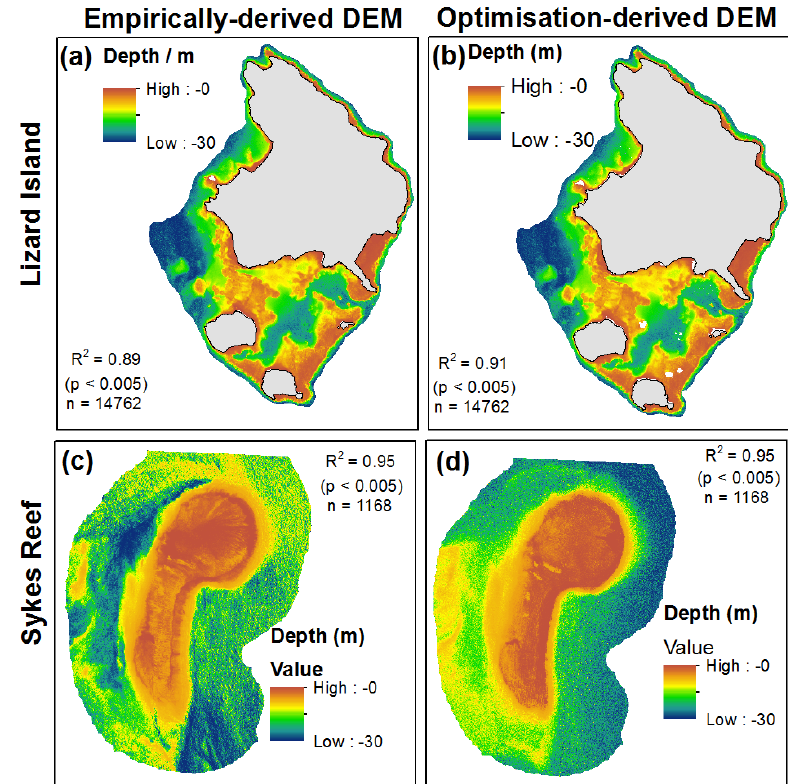
Figure 5. Final DEMs of Lizard Island and Sykes Reef derived from satellite images after the spatial structure of errors associated with depth estimates have been characterised and accounted for in the DEMs (from left to right, top to bottom): ( a ) Lizard Island empirical model; ( b ) Lizard Island optimisation model; ( c ) Sykes Reef empirical model; ( d ) Sykes Reef optimisation model.